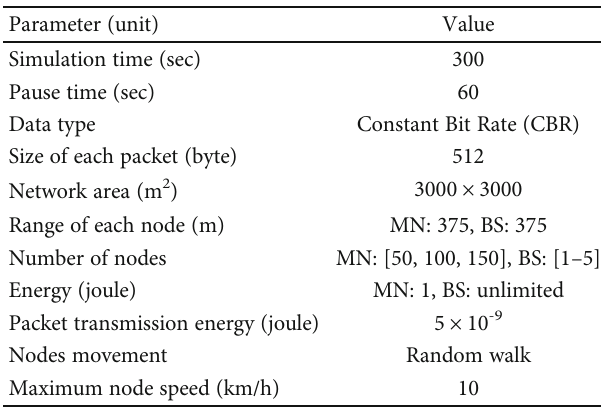
Figure 10: Processing the output of the U-net-similar part to achieve dueling Q-learning. Table 1: Parameters of the experimental